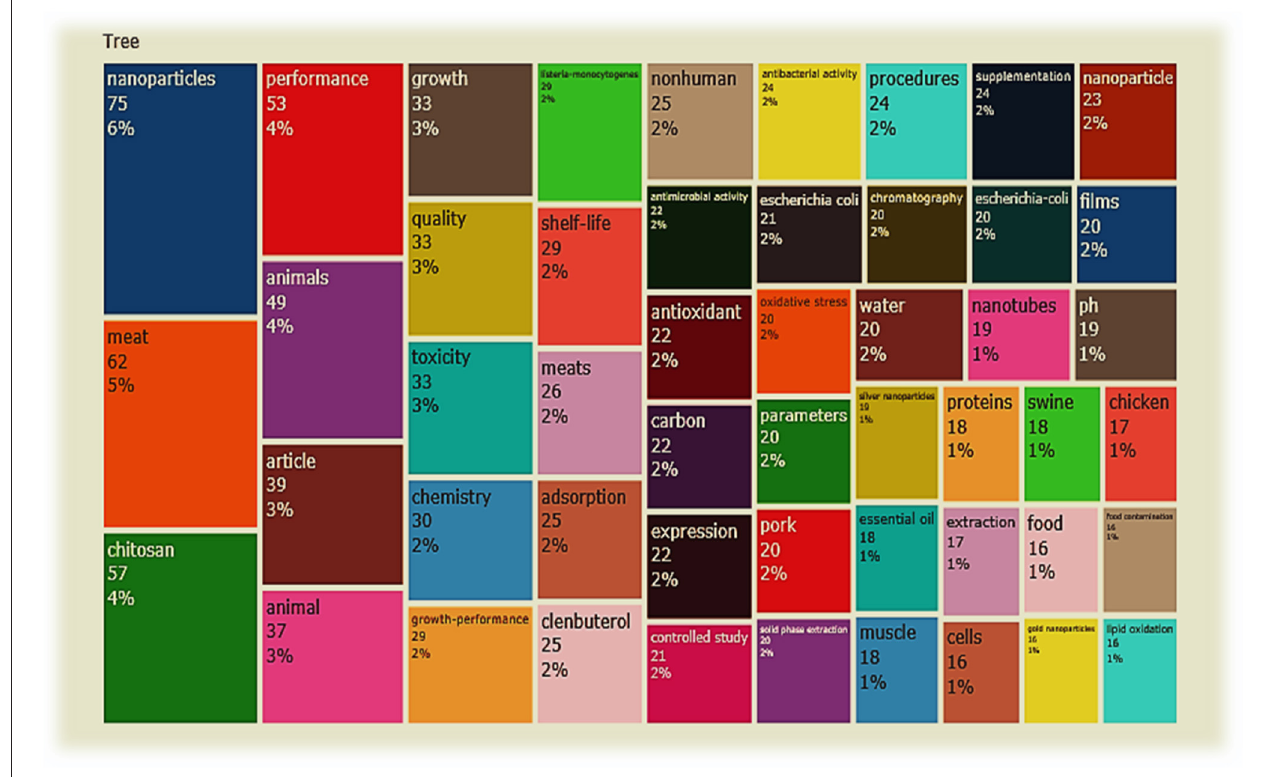
FIGURE 6 | Tree map of discipline distribution in the field of meat production and nanotechnology research.